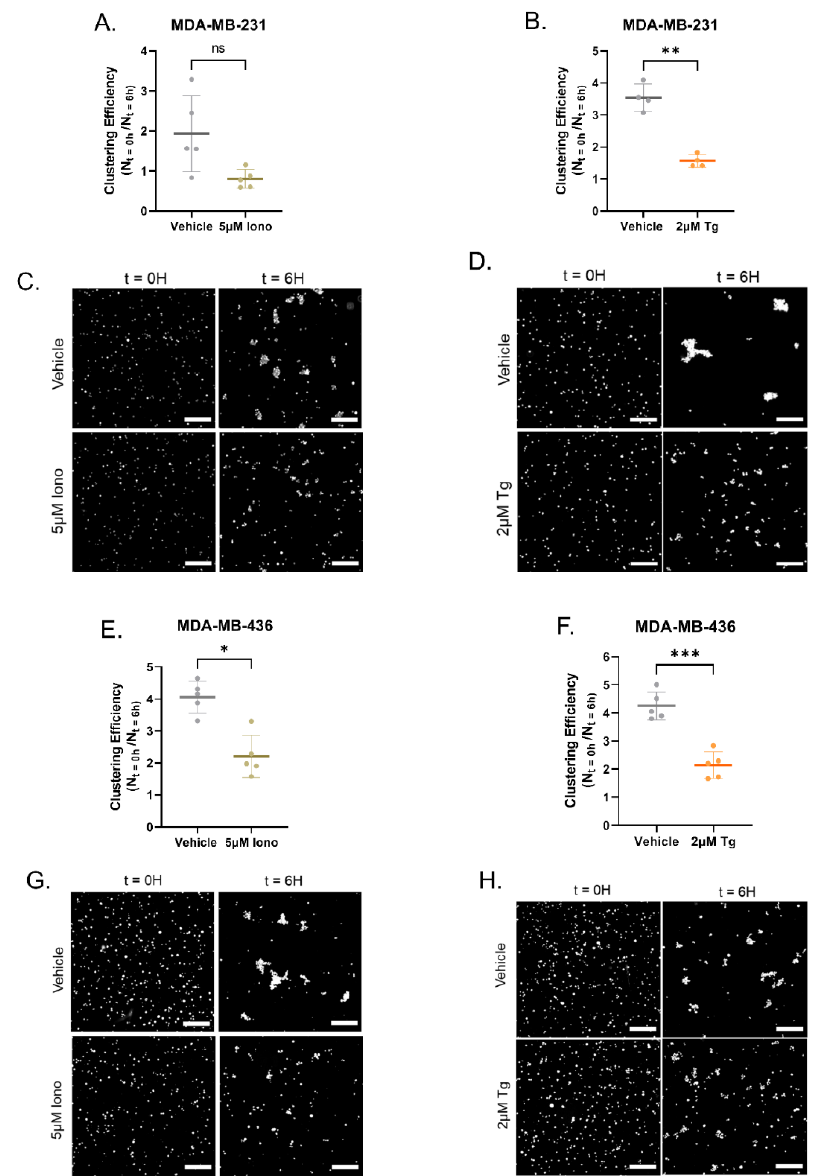
Figure 5. Induced elevation of cytoplasmic Ca 2+ in MDA-MB-231 and MDA-MB-436 cells decreases homotypic clustering. ( A ) Trending decrease of clustering efficiency with a treatment of 5 μM Iono- mycin in MDA-MB-231 cells over 6 h. Data are shown as mean ± SD, n = 5. ( B ) MDA-MB-231 cells with 2 μM Thapsigargin 6 h treatment significantly decreases clustering efficiency. Data are shown as mean ± SD, n = 4; a fifth biological replicate was removed because it was identified as an outlier with the ROUT test with a Q = 1%. ( C ) Representative zoomed black and white images of nuclear staining show MDA-MB-231 cells with 5 µM Ionomycin and vehicle treatment density at t = 0 and t = 6 h. ( D ) Representative enlarged region of interest black and white images of Hoescht staining show MDA-MB-231 cells with 2 μM Thapsigargin and vehicle treatment density at t = 0 and t = 6 h. ( E ) 5µM Ionomycin treatment in MDA-MB-436 cells decreases clustering efficiency over 6 h. ( F ) Thapsigargin treatment in MDA-MB-436 cells significantly decreased clustering efficiency in com- parison to the vehicle control. ( E , F ) Data shown as mean ± SD of 5 independently conducted ex- periments. ( G ) MDA-MB-436 representative enlarged black and white images of nuclear staining shows 5 µM Iono and vehicle treatment density at t = 0 and t = 6 h. ( H ) Representative enlarged black and white MDA-MB-436 images of nuclear staining shows 2 µM Tg and vehicle treatment density at t = 0 and t = 6 h. n.s., * p < 0.05, ** p < 0.01, and *** p < 0.001. Scale bar = 250 μM .